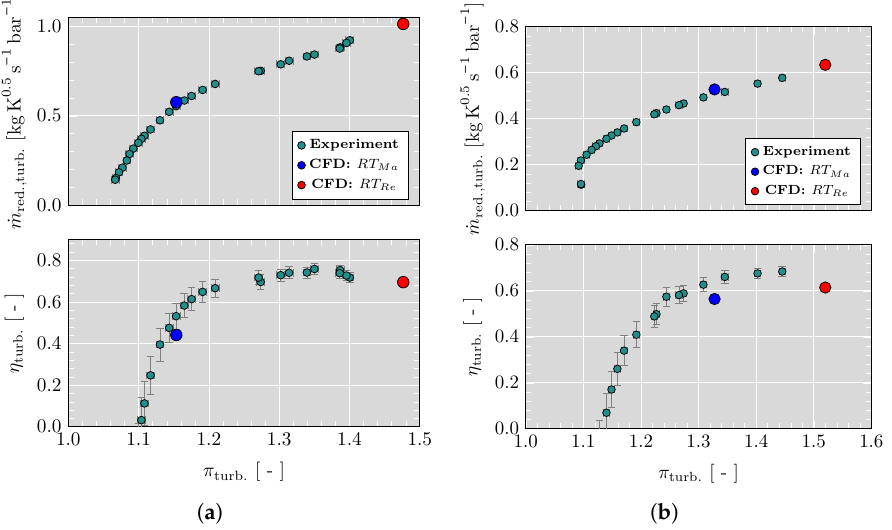
Figure 3. Real turbine map at 3890 rpm/K 0.5 . ( a ) VGT60. ( b ) VGT30. Table 2. Boundary conditions: